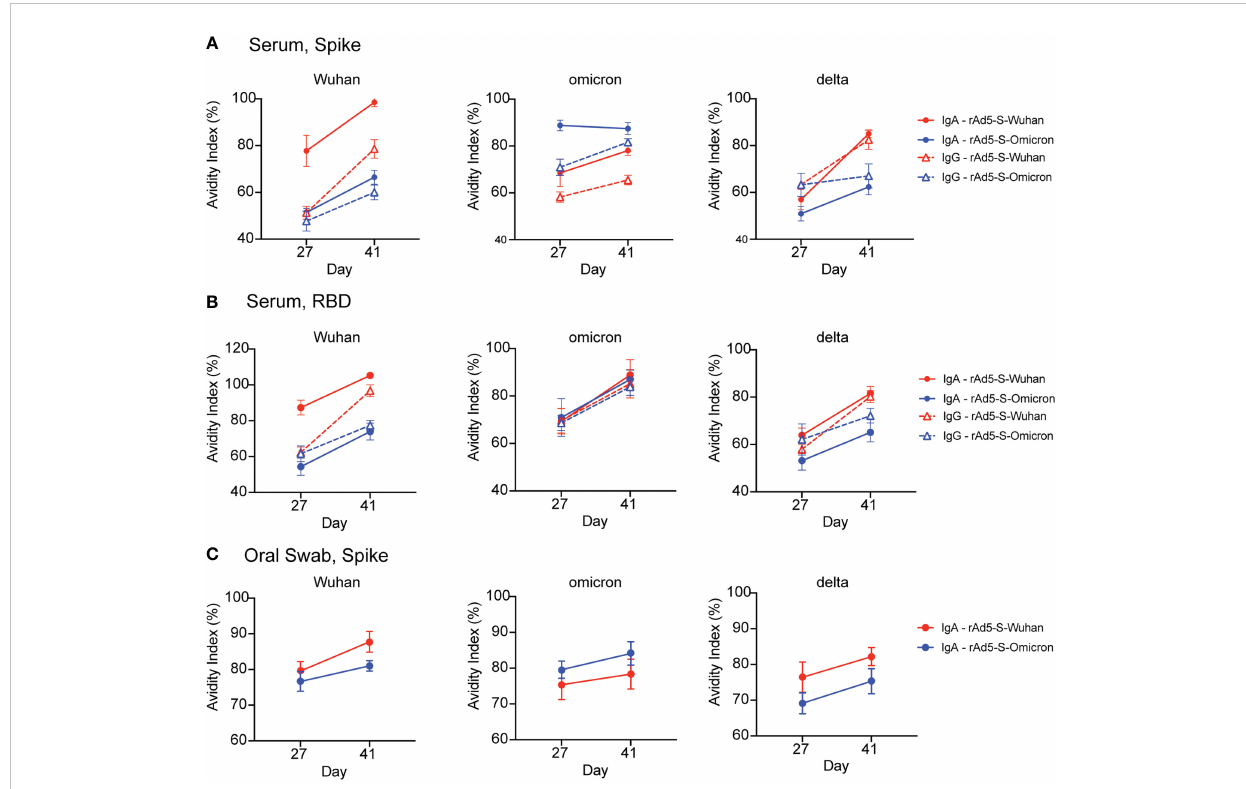
FIGURE 4 Antibody avidity following prime and boost vaccination. (A, B) Avidity index of serum IgA (solid lines, circles) and IgG (dashed lines/triangles) at D27 and D41 against SARS-CoV-2 spike (A) and RBD proteins (B) . (C) Avidity index of IgA eluted from oral swabs at D27 and D41 against SARS-CoV-2 spike protein. Mean and SEM